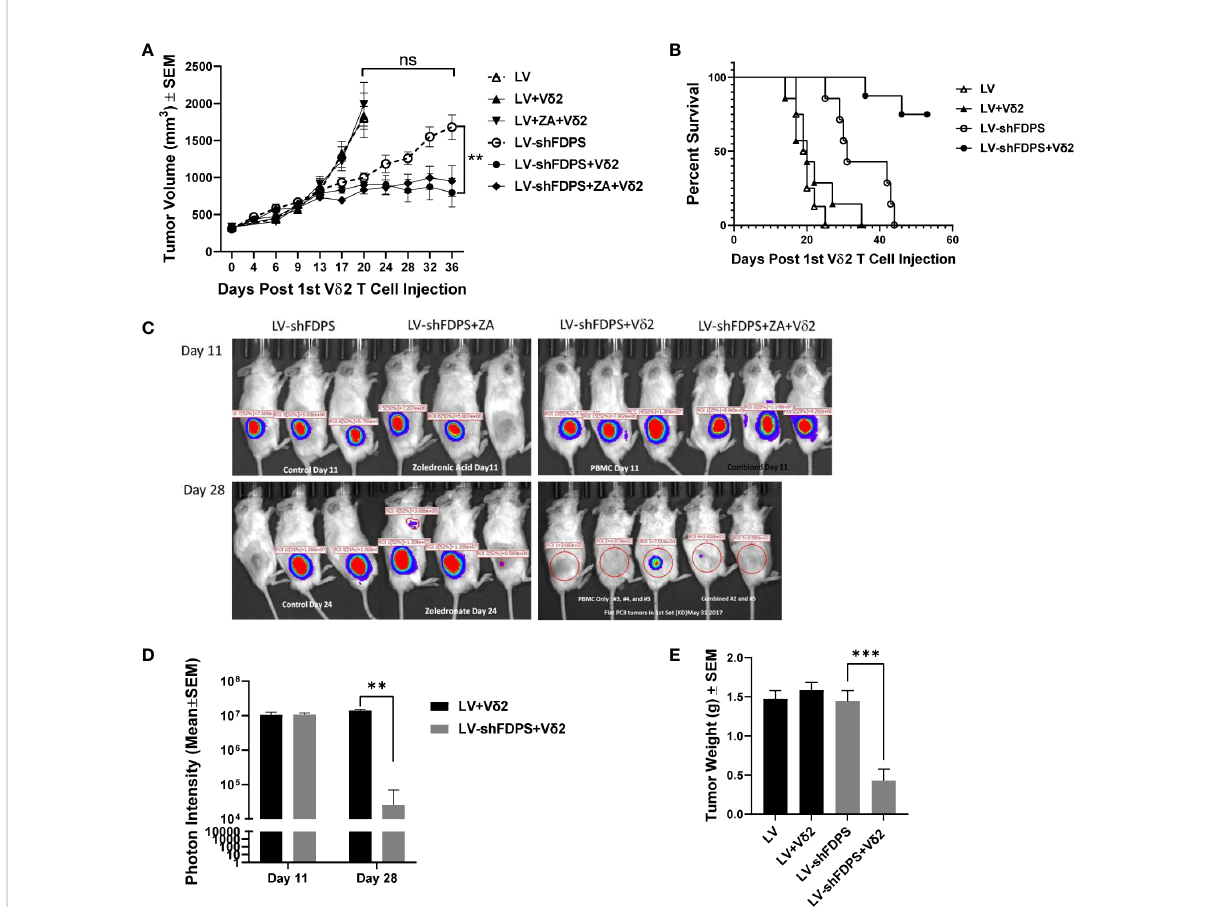
FIGURE 3 V d 2 T cells suppress the growth of PC3 prostate carcinoma tumors transduced with a lentivirus expressing a shRNA targeting FDPS. (A) V d 2 T cells signi fi cantly suppressed the growth of PC3 tumors transduced with LV-shFDPS as compared with LV (**p<0.0037, N=8). At the end of the study, 36 days post V d 2 injection, the average tumor volume for LV-shFDPS was 1680 ± 166 mm 3 which was reduced to 795 ± 193 mm 3 when combined with V d 2 treatment. There was minimal effect on tumor volume with ZA treatment with or without LV-shFDPS. (B) An analysis using a Kaplan-Meier survival curve was based on the end event being when the tumor size reached 2000 mm 3 . There was a signi fi cant survival advantage in mice with PC3 tumors transduced with LV-shFDPS and treated with V d 2 T cells as compared with no V d 2 T cells (**** p < 0.0001, N=8). All mice with LV transduced PC3 tumors with or without treatment of V d 2 T cells were sacri fi ced up to day 22. In mice with LV-shFDPS transduced PC3 tumors, mice survived up to day 44, and with V d 2 T cell treatment all mice survived up to day 60. (C, D) Mice were imaged